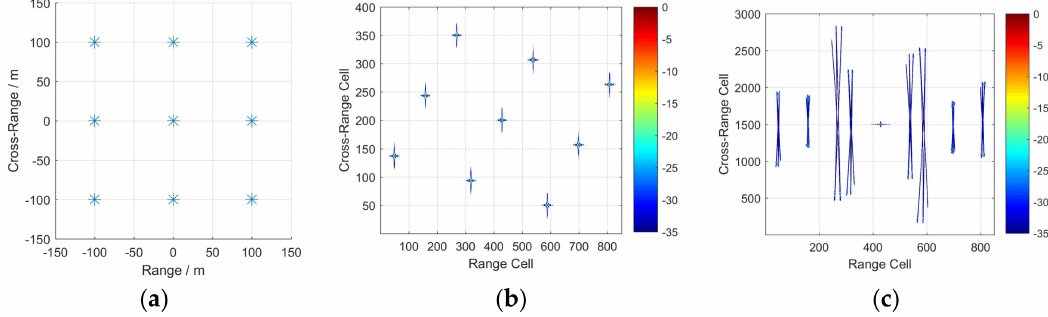
Figure 2. Scattering point model and imaging result of the simulation. ( a ) Scattering point model; ( b ) imaging result without motion; and ( c ) imaging result with motion.